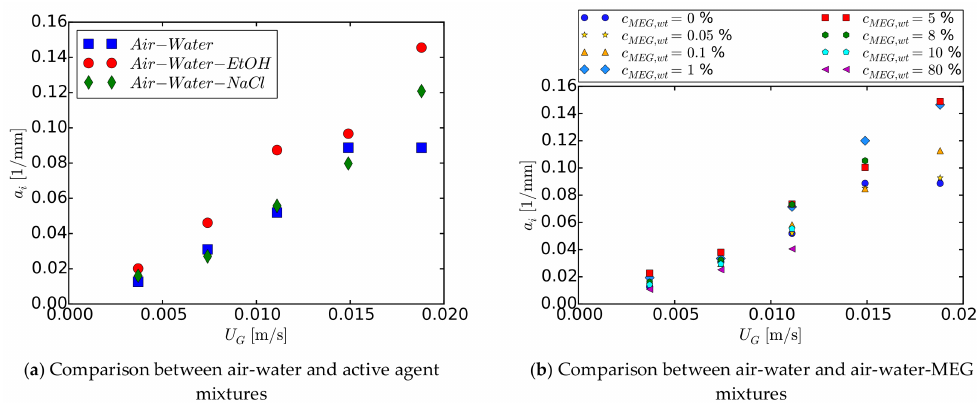
Figure 28. Influence of the liquid phase properties on the interfacial area—data from ref.